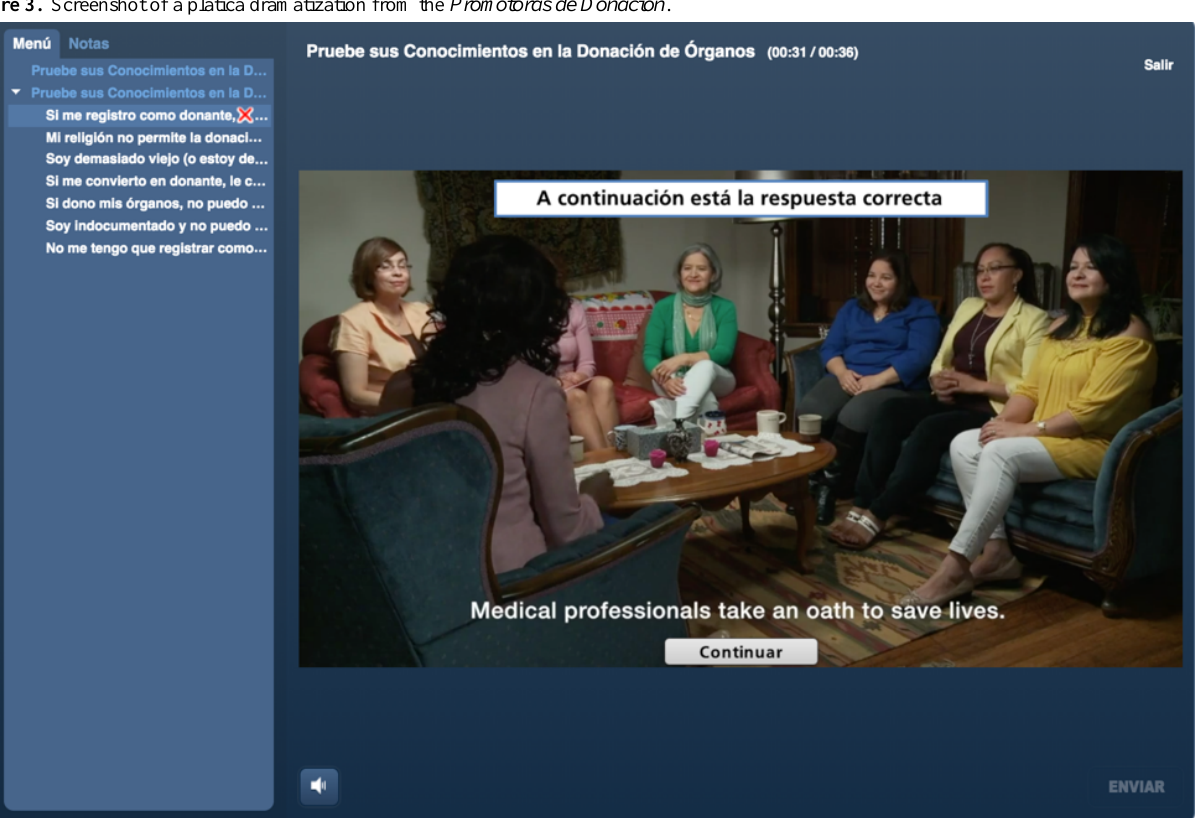
Figure 3. Screenshot of a platica dramatization from the Promotoras de Donación .